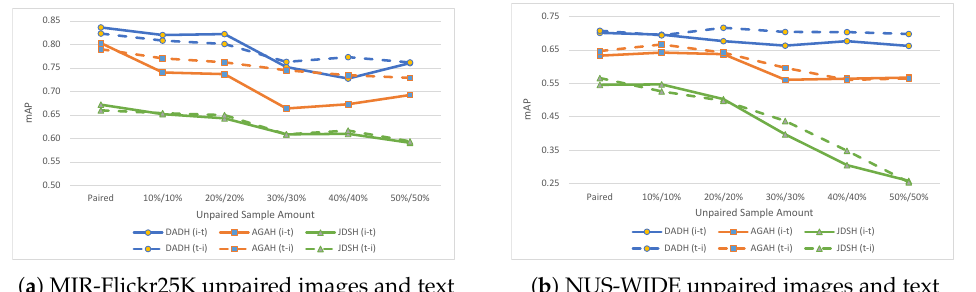
Figure 7. Results (mAP) on MIR-Flickr25K and NUS-WIDE with unpaired images and text, i.e., im- ages with no corresponding text and vice versa. The ‘Paired’ points show results when training with a fully paired training set. Subsequent points show results with increasing amounts of unpaired images and text in the training set, for example, ‘10%/10%’ refers to 10% of the training set being unpaired images and another 10% being unpaired text for a total of 20% of the dataset being unpaired samples.